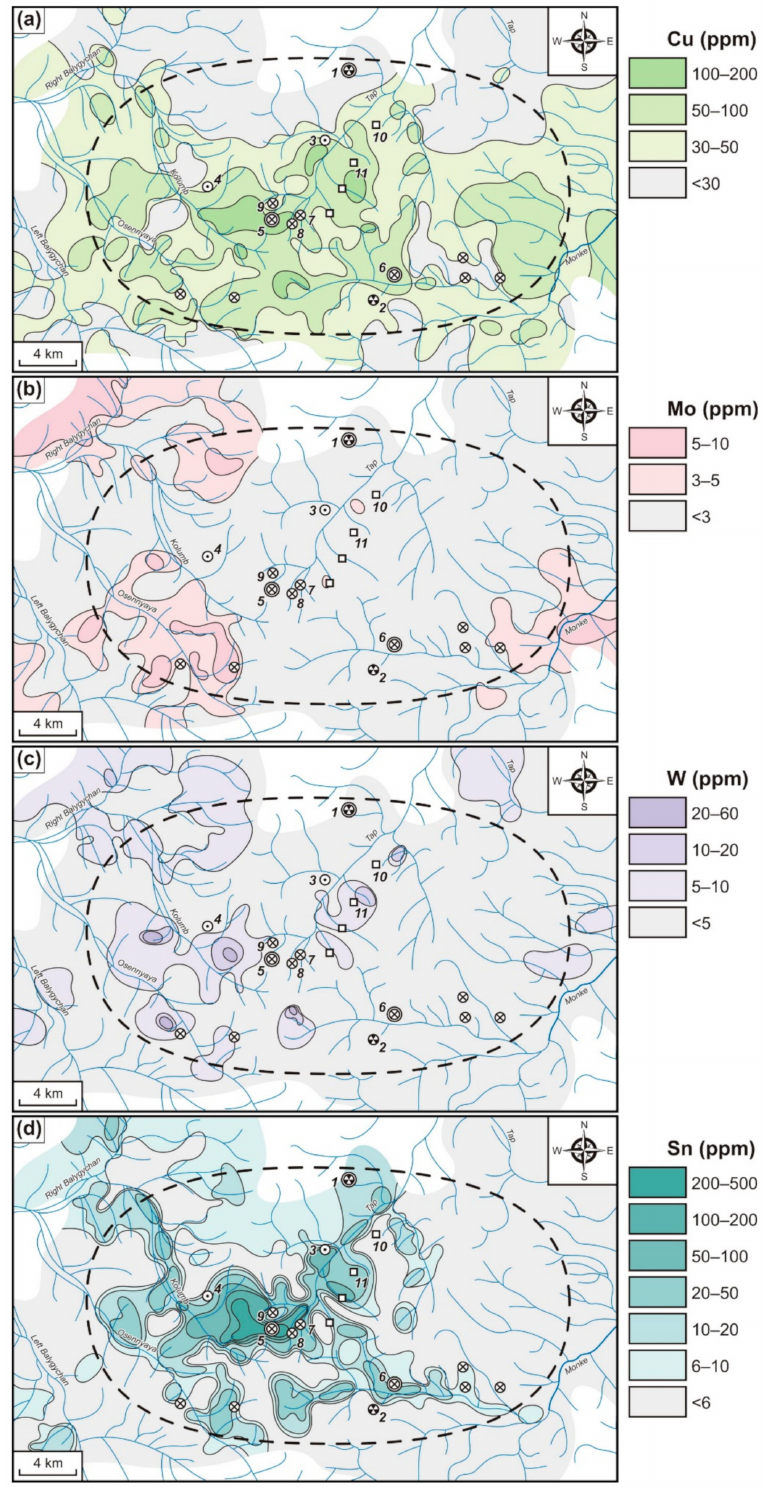
Figure 4. The Pestrinsk SBS. Exogenous Cu ( a ), Mo ( b ), W ( c ) and Sn ( d ) AGCFs identified through SSs (survey at 1:200,000